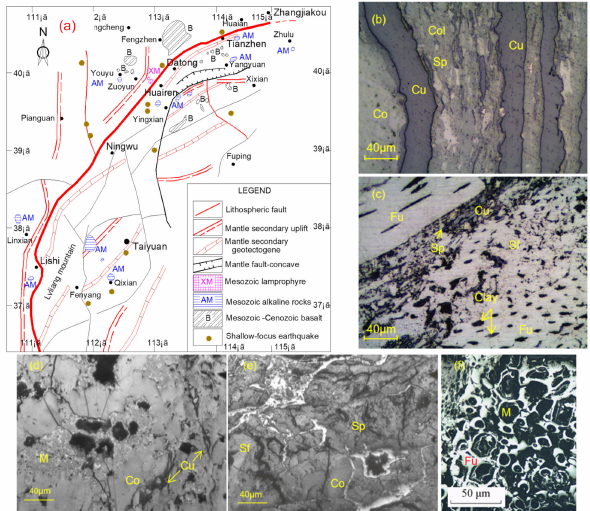
Figure 7. ( a )—Internal tectonic sketch in northern Shanxi [48]; ( b – f ) The samples of No. 8 coal from Taiyuan Formation of Wujiayao, Datong (reflected white light, oil immersion); ( b , c )—The normal coal macerals; ( d – f ) The contact metamorphism coal macerals exhibit deformation, charking, and mineralization; Co—collotelinite; Col—collodetrinite; Cu—cutinite; Sp—sporinite; Fu—Fusinite; Sf—semifusinite;